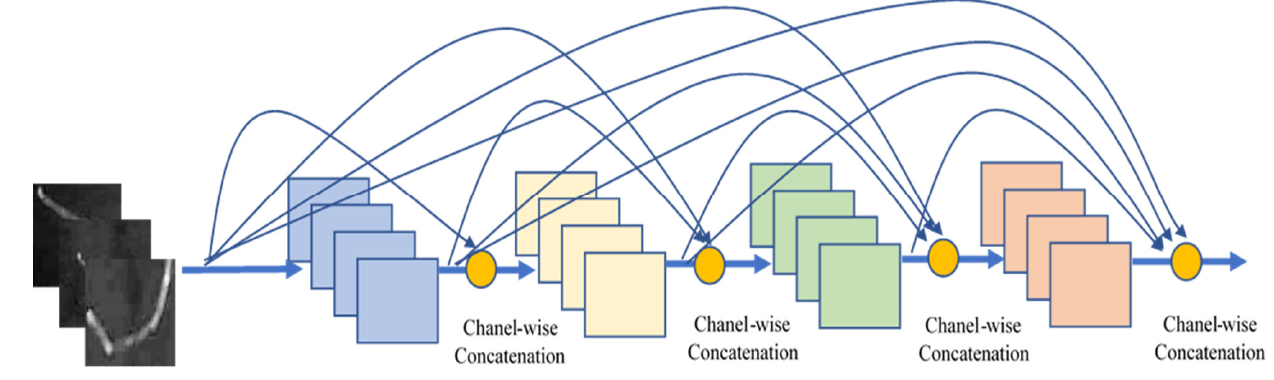
Figure 4. Connection in DenseNet.